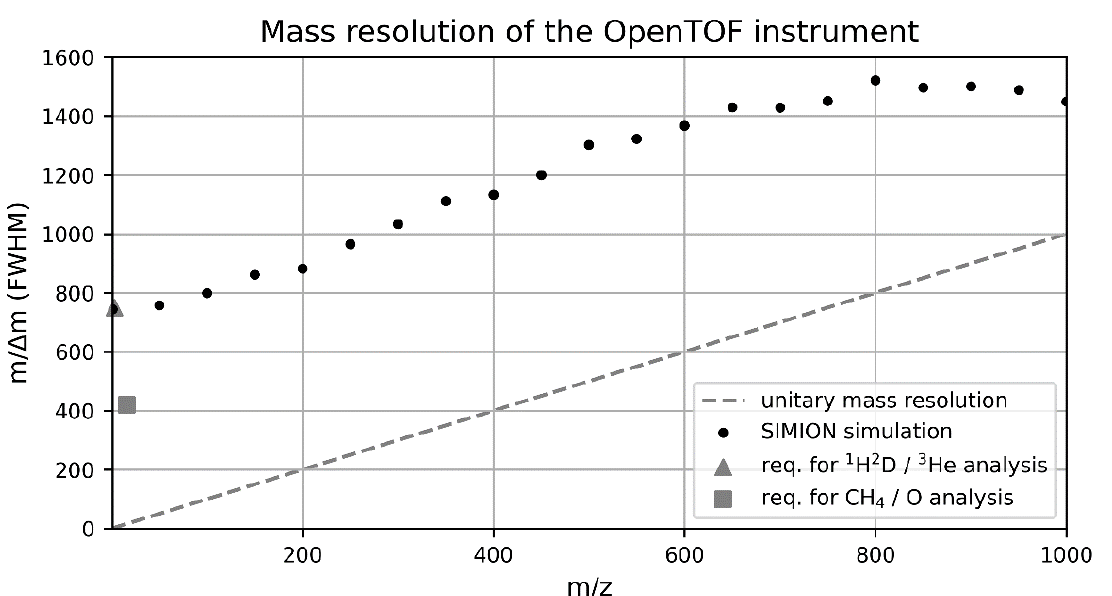
Figure 4. The OpenTOF instrument resolves 3 He + and 1 H 2 D + ( a ) and 16 O + and CH 4 + ( b ). The mass resolution of about 1400 (FWHM) at m/z 1000 constrains the mass range of the instrument ( c